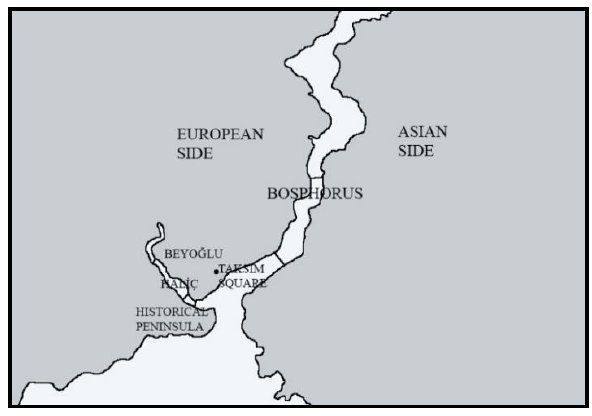
Figure 1. Location of Taksim Square in Istanbul, map